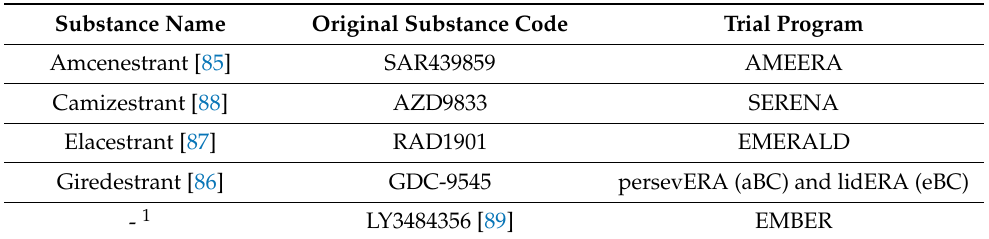
Table 2. Selection of novel SERDs under clinical development in phase III eBC/aBC trials (in alphabetical order; based on clinicaltrials.gov, accessed on 22 September 2021)